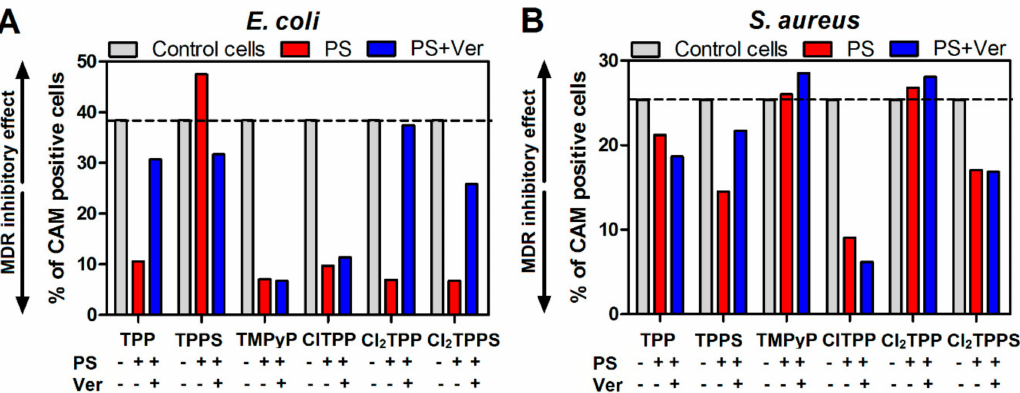
Figure 20. Regulation of drug e ffl ux in the photosensitizer-treated bacteria: ( A ) E. coli and ( B ) S. aureus . After the treatment of cells with 20 µ M PS for 2 h, 0.25 µ M calcein AM was added to the cells, and the calcein AM retention was examined. Greater numbers suggest a more significant inhibitory e ff ect on MDR